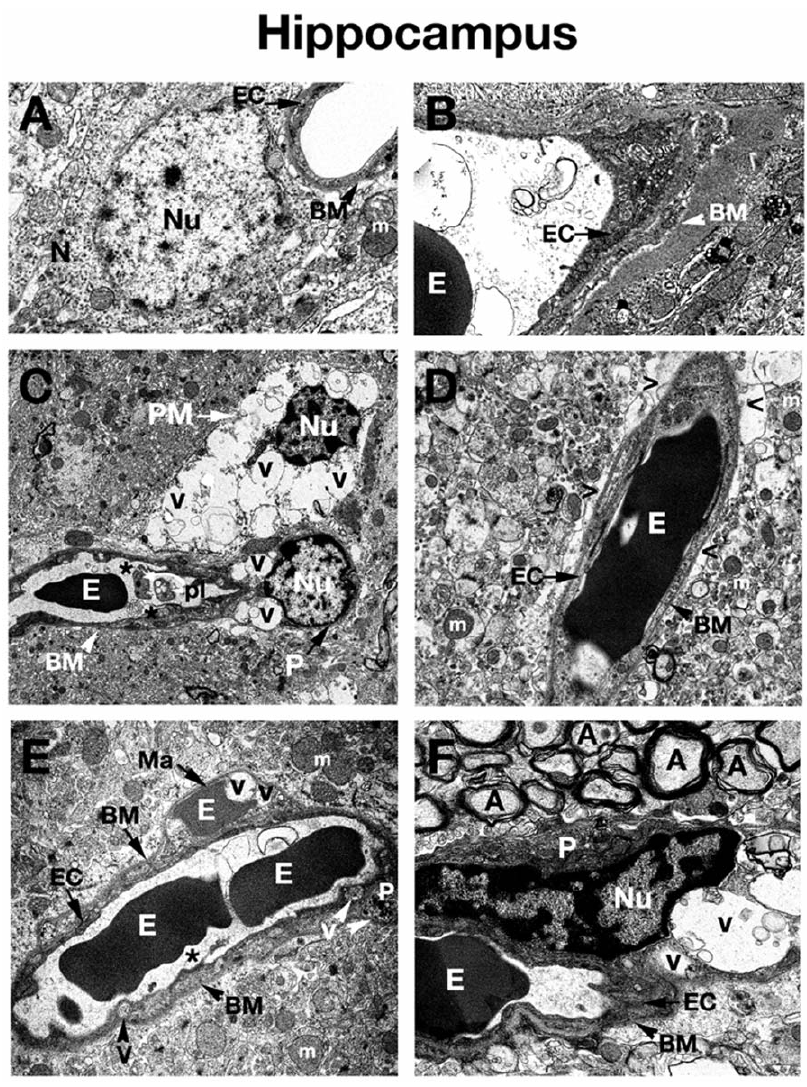
Figure 2. Electron microscope examination of the hippocampus of Naglu mutant mice. ( A ), ( B ) Hippocampal area of C57 BL/6J control mouse shows typical normal ultrastructure of neurons and all capillary components. ( C ) Vacuolated endothelial cells and pericytes can be observed in 3 months old Naglu mouse. A highly vacuolated perivascular macrophage was also noted. Platelets attracted to a region of endothelial cell damage are visible. ( D ) Perivascular space can be observed around the capillaries in the hippocampus of an early symptomatic mouse at 3 months of age. ( E ) In Naglu mouse at 6 months of age, a microaneurysm is visible in the hippocampus, adjacent to a ruptured endothelium. In the microaneurysm, an erythrocyte can be seen trapped under the basement membrane, portending imminent aneurysm rupture. ( F ) Under high magnification, distended nucleus of pericyte with large vacuoles can be observed in late symptomatic mutant mouse. EC - endothelial cell, BM - basement membrane, E – erythrocyte, m – mitochondrion, A – axon, N – neuron, P – pericyte, PM – perivascular macrophage, Nu – nucleus, V – vacuole, Ma – microaneurysm, pl – platelets, asterisks - microvilli, . - extracellular edematous space. Magnifications: ( A ), ( B ), ( D ), ( E ): 7,100x; ( C ): 3,500x; ( F ): 8,900x. revealed endothelial cell damage and astrocyte degeneration which compromised the BBB, resulting in vascular leakage, (2) endothelial cells showed endoplasmic reticulum swelling and formation of numerous large cytoplasmic vacuoles, degeneration of cytoplasmic organelles, abnormal microvilli formation, and shedding of fragments of cell membrane and microvilli, (3) edematous space was detected surrounding microvessels, (4) pericyte degeneration was observed in the large majority of damaged vessels, (5) highly vacuolated perivascular macrophages were found in contact with microvessels, (6) a microaneurysm was